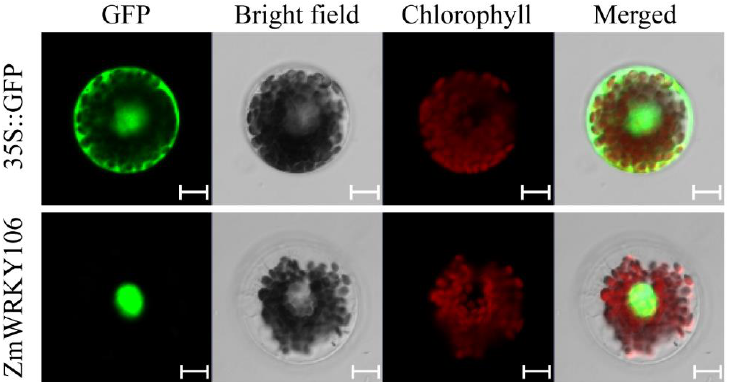
Figure 3. Subcellular localization of ZmWRKY106 . The p16318hGFP and p16318hGFP-ZmWRKY106 constructs were transiently expressed in maize protoplasts. The green indicates green fluorescent, and the red indicates chloroplast autofluorescence. Results were observed after transformation for 18 h with confocal microscopy. Scale bars = 10 μm.